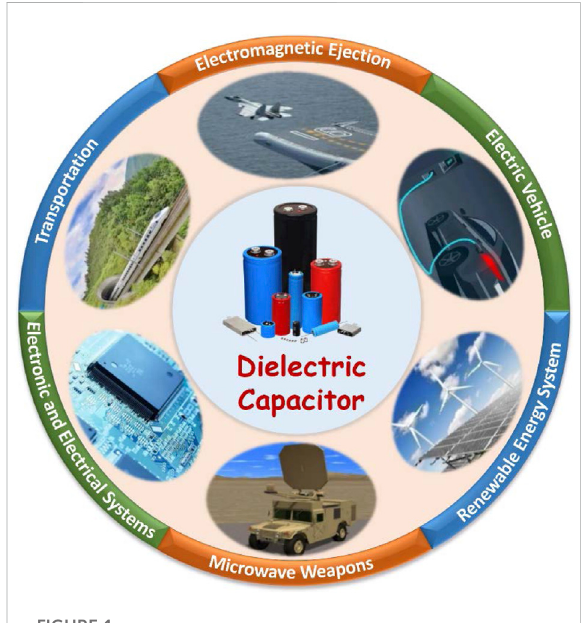
FIGURE 1 Application fi elds of dielectric capacitors, including electric vehicle, transportation, electronic and electrical systems, renewable energy system, electromagnetic ejection, and microwave weapons.